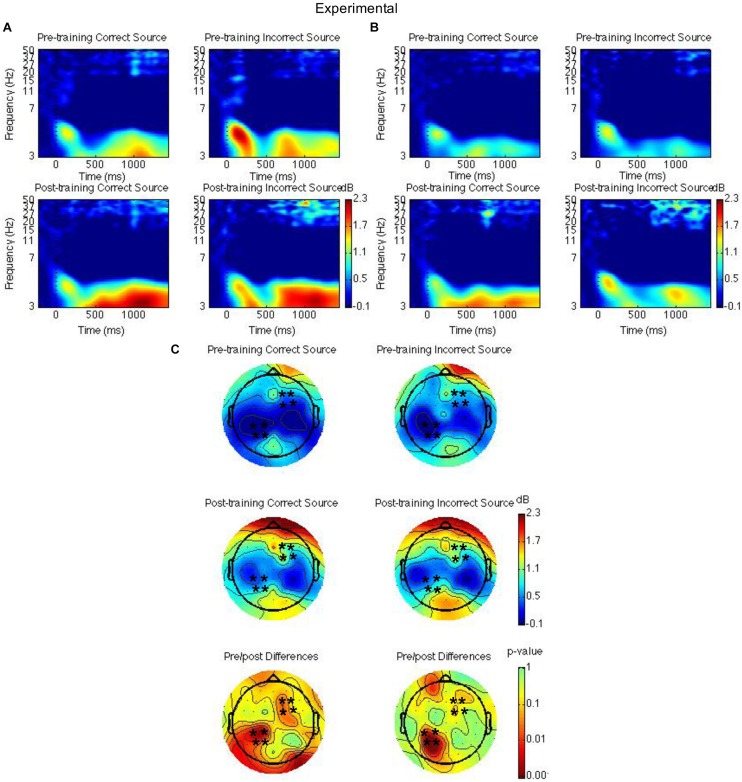
Theta power for the mindfulness meditation experimental group for the pre-training compared to the post-training session for hits with correct source and hits with incorrect source. Time-frequency spectrograms across times and frequencies in a right frontal channel (A). Time-frequency spectrograms across times and frequencies in a left parietal channel (B). Theta power across all channels from 1000 to 1500 ms and differences from pre-training to post-training. Black ∗ marks analyzed channels in right frontal and left parietal regions (C). Color scale: decibel change from pre-stimulus baseline and p-value of pre-training to post-training differences.